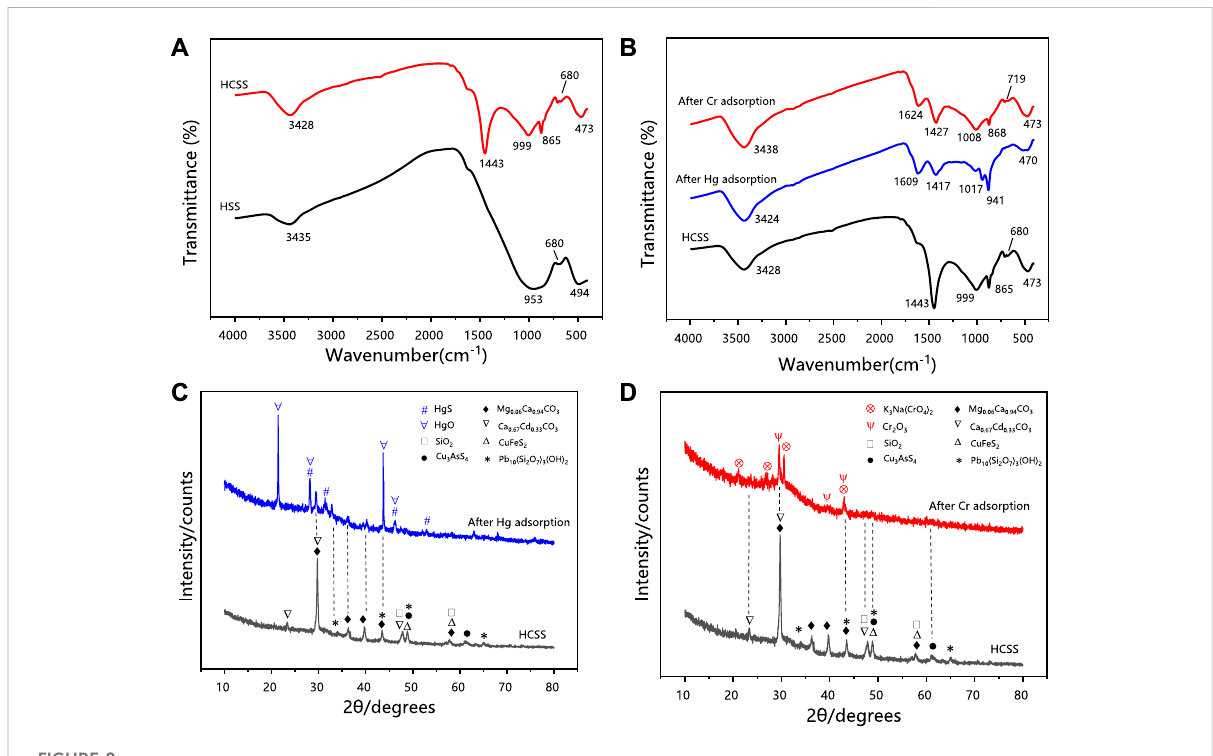
FIGURE 8 (A) FT-IRpatternsofHCSSbeforeadsorption. (B) FT-IRpatternsofHg-adsorbedHCSS,Cr-adsorbedHCSS,andcomparisonwithHCSS. (C) XRD patterns of Hg-adsorbed HCSS. (D) XRD patterns of Cr-adsorbed